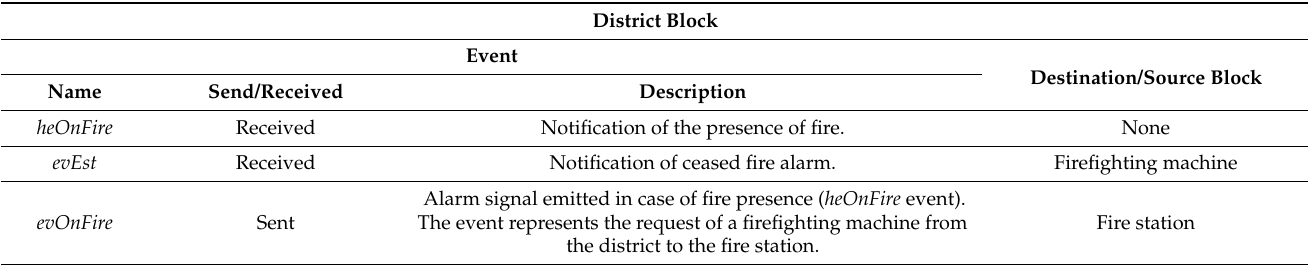
Table 1. Events list of the district CS block with event name, direction (send/received), description, and its destination/source block.